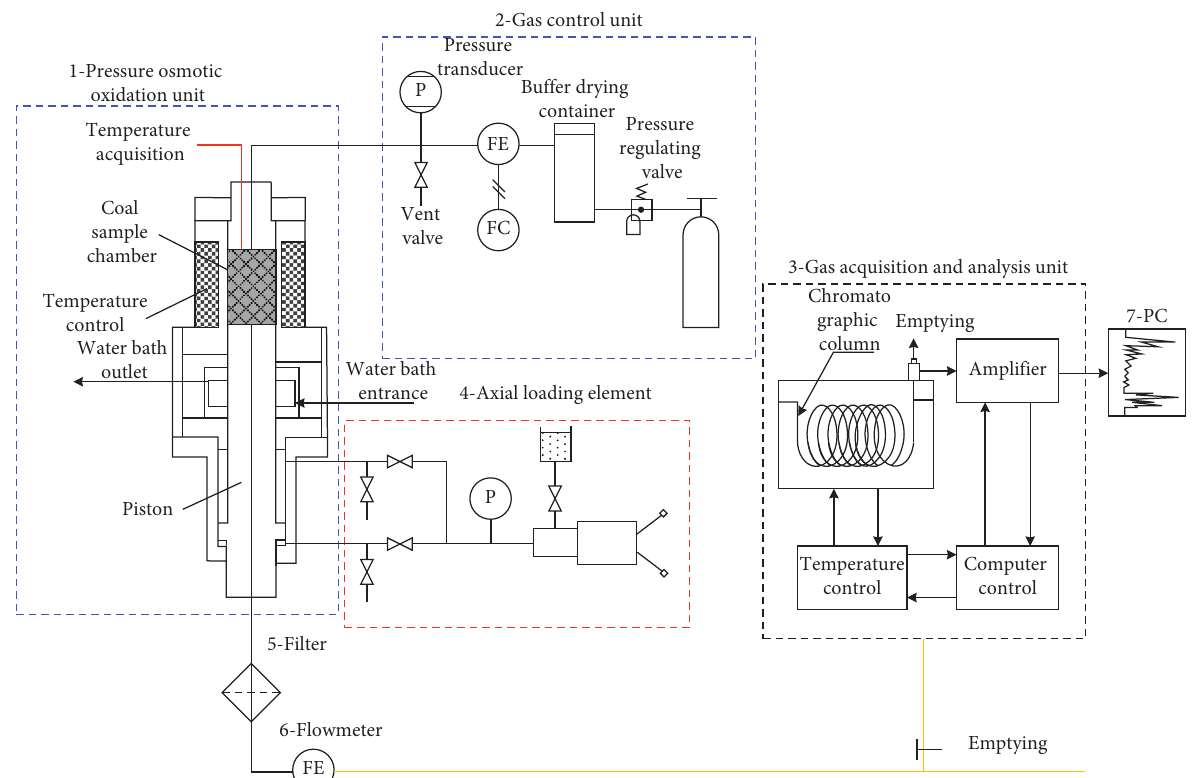
Figure 5: The porosity measurement of the compacted experiment of broken coal: (1) pressure osmotic oxidation unit; (2) gas control unit; (3) gas acquisition and analysis unit; (4) axial loading element; (5) filter; (6) flowmeter; (7)